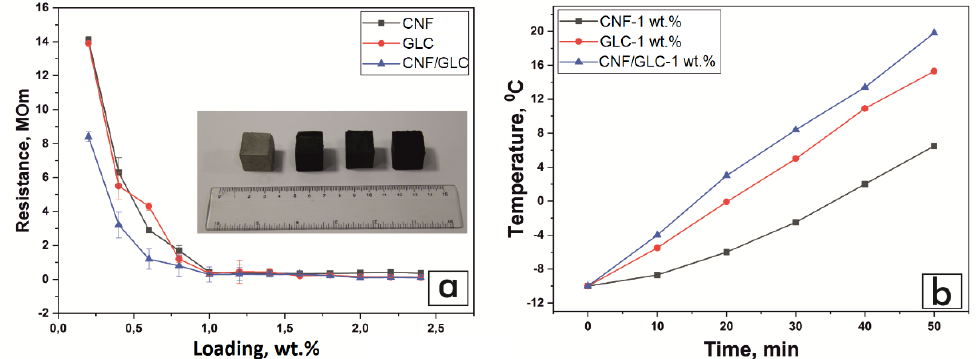
Figure 6. Plots of electrical resistance as function of filler loading ( a ) and concrete specimen temperatures as function of electric current passage time ( b ) for concrete samples with different carbon additives at 1 wt.% filling rate.